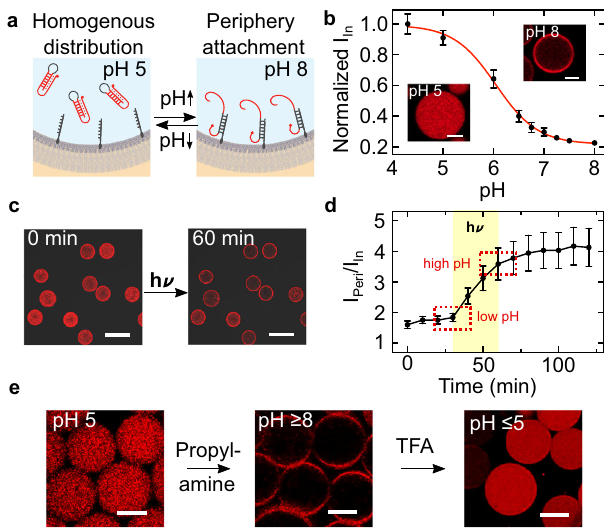
Fig. 3 pH-sensitive DNA attachment to the droplet periphery stimulated with engineered E. coli . a Schematic illustration of pH-sensitive duplex formation at the droplet periphery. In response to higher pH, the DNA triplex motif opens up and reversibly attaches to the cholesterol-tagged DNA handles at the compartment periphery. b Normalized fl uorescence intensity of triplex-forming DNA inside the droplet (excluding the periphery) dependent on the pH (mean ± s.d., n = 20). The sigmoidal fi t (red curve) has a turning point at pH 6.05. The insets depict confocal fl uorescence images of Cy5-labeled triplex-forming DNA ( λ ex = 633 nm, 1 μ M) inside a water-in-oil droplet (containing 1.5 μ M cholesterol-tagged DNA) at pH 5 (bottom left) and pH 8 (top right). At pH 8, the triplex- forming DNA is located at the droplet periphery, whereas it is homogeneously distributed at pH 5. Scale bars: 20 μ m. c Confocal images of micro fl uidic water-in-oil droplets containing the triplex-forming DNA ( λ ex = 633 nm), cholesterol-tagged DNA and engineered E. coli before (0 min) and after (60 min) illumination with white light. Scale bars: 100 μ m. d Fluorescence intensity ratio I peri /I in (mean ± s.d., n = 20) of the triplex- forming DNA over time. The ratio increases during light illumination due to binding of the triplex-forming DNA to the droplet periphery. The time period of illumination is indicated in yellow. e Confocal images of micro fl uidic water-in-oil droplets containing the triplex-forming DNA ( λ ex = 633 nm) and cholesterol-tagged DNA produced at pH 5 (left image). Flushing of the proton acceptor propylamine (1 vol% in HFE) led to a pH increase of the aqueous solution inside the droplets and hence attachment of the triplex-forming DNA (middle). Subsequent fl ushing of the proton donor tri fl uoroacetic acid (1 vol% in HFE) decreased the pH and hence causes DNA detachment (right). The attachment of triplex-forming DNA to the droplet periphery is reversible. Scale bars: 30 μ m. Source data is available for Fig. 3b,